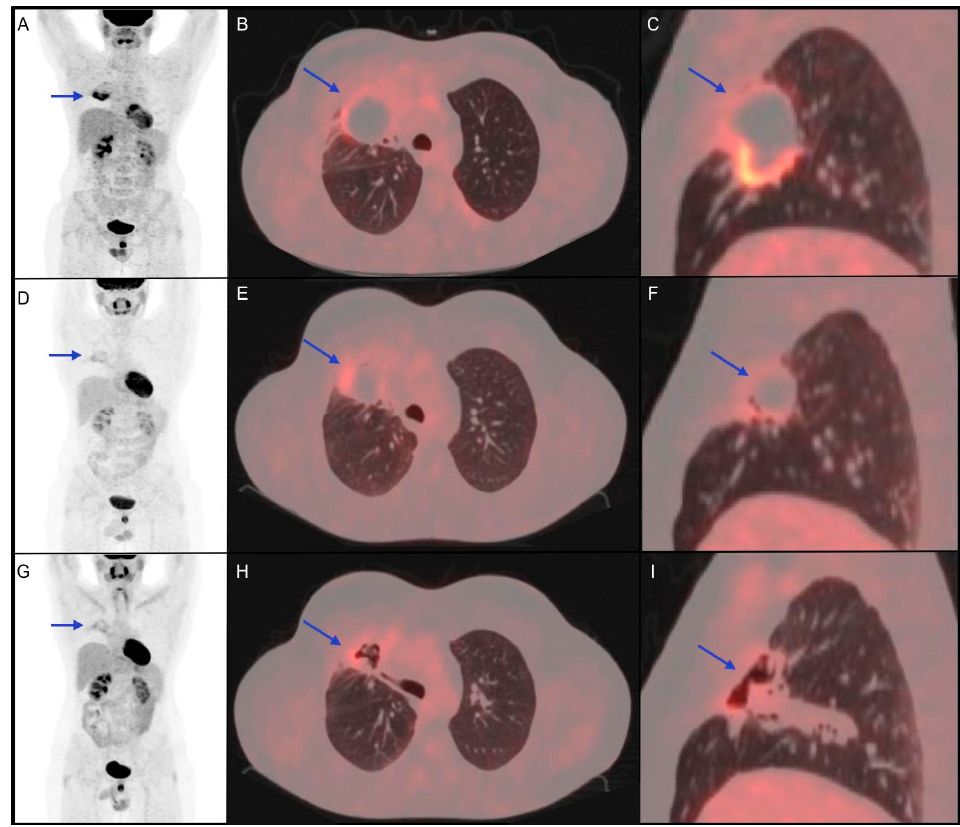
Figure 4. Clinical case of a 34-year-old male patient affected by diffuse large B-cell lymphoma diagnosed with biopsy of mediastinal mass, with right lung involvement, in June 2016. He underwent radio-chemotherapy with R-CHOP, R-DHAP and R-IEV with a subsequent stem cell transplant in June 2017. In March 2018, the persistence of the right lung lesion led haematologists to choose a following therapeutic option immune checkpoint inhibitor (pembrolizumab). ( A – C ) 18F-FDG PET/CT performed before the start of immunotherapy shows a metabolically active right lung lesion (blue arrow, SUVmax 8.7). ( D – F ) 18F-FDG PET/CT performed 5 months after the start of immuno-treatment shows partial metabolic response of the known lesion with a reduction of SUVmax (blue arrow, SUVmax 4.2). ( G – I ) 18F-FDG PET/CT 4 months after the end of immunotherapy shows further metabolic reduction (SUVmax 3.5) of the lung lesion, which appeared excavated on CT coregistered to PET images. The patient was followed-up with stable disease until December 2020, when progression disease was documented.